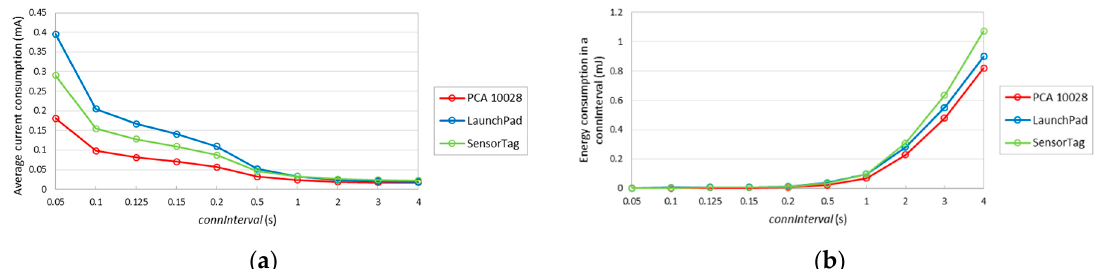
Figure 11. ( a ) Average current consumption for different connInterval settings, without data packet transmission; ( b ) energy consumption during a connection interval, without data packet transmission, as a function of connInterval .